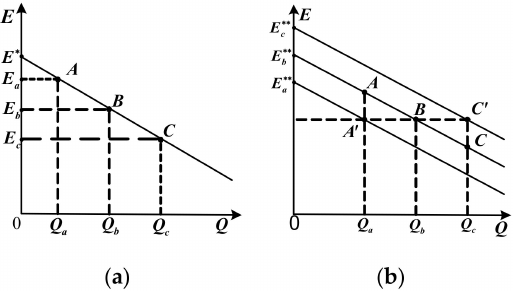
Figure 8. Q - U droop curves. ( a ) Traditional Q - U droop curve; ( b ) Improved Q - U droop